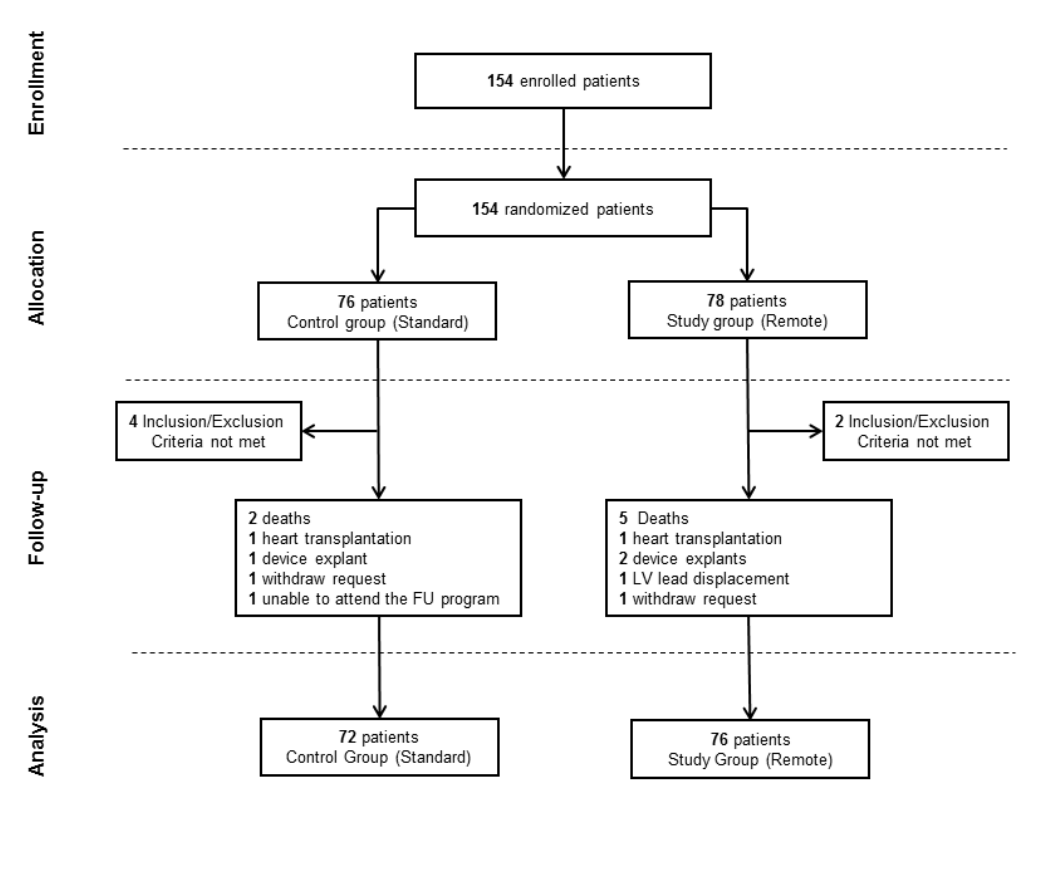
Figure 3. Phase 1 follow-up experience flow-chart.